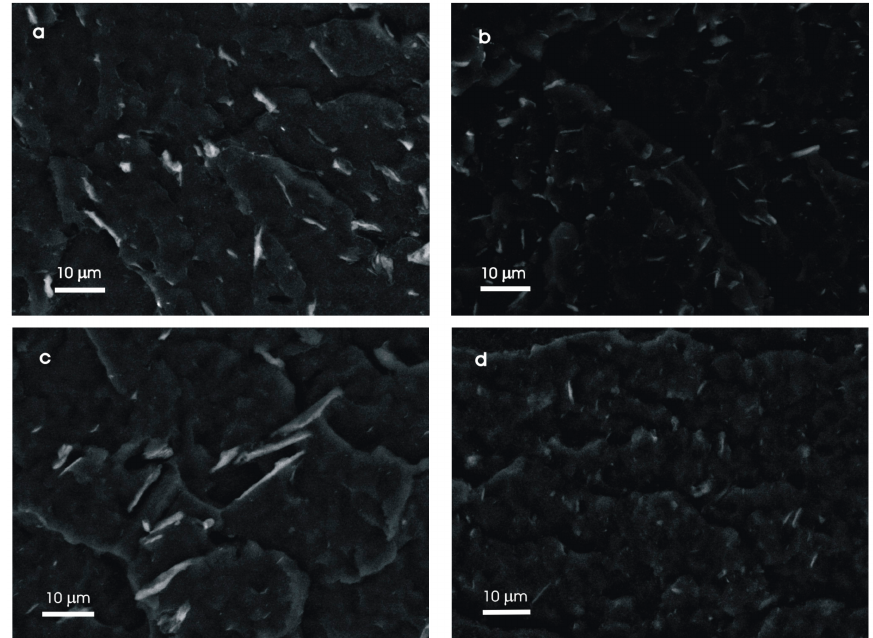
Figure 9. SEM micrographs (back-scattered electrons) of CNC/LLDPE composites, showing CNC distribution in the LLDPE matrix as a function of molding temperature and CNC surface modification: ( a ) 70 ◦ C and unmodified CNCs; ( b ) 70 ◦ C and CNCs modified with AcAnh; ( c ) 120 ◦ C and unmodified CNCs; ( d ) 120 ◦ C and CNCs modified with AcAnh. In all cases, the mass share of CNCs was 5 wt